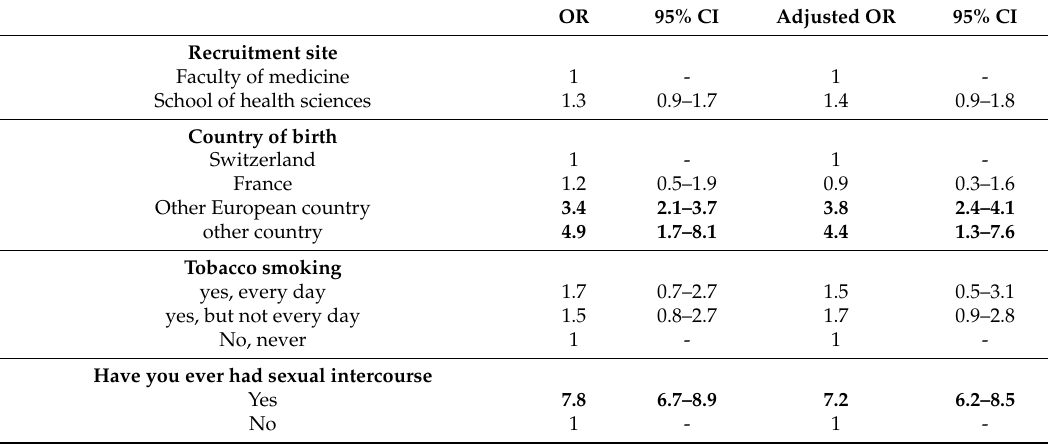
Table 2. Association between HPV positivity and socio demographic